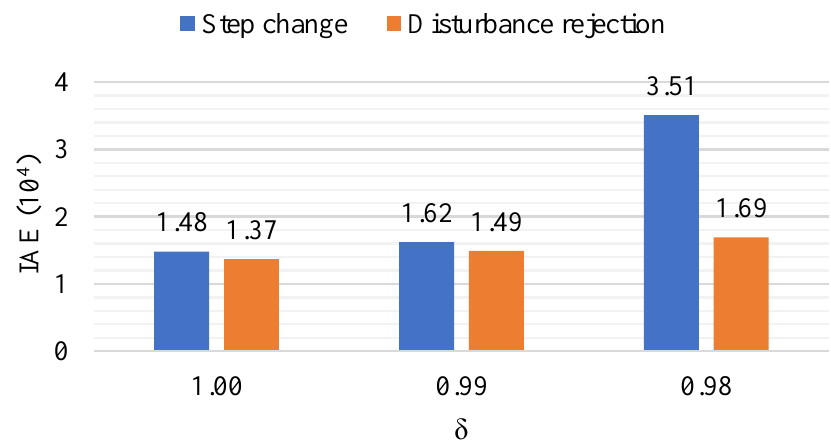
Figure 10. The effect of the forgetting factor ( δ ) on the adaptive controller performance.